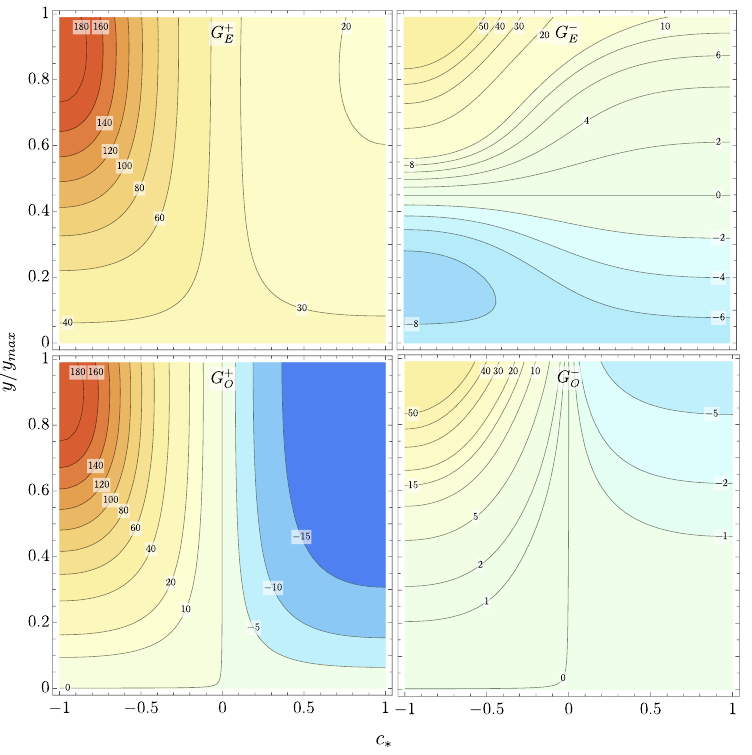
Figure 3 . Logarithmic derivative of the tree-level differential cross-section with respect to the G ± coefficients in the ( c ∗ , y ) plane. The plots are obtained setting m ‘‘ = 1 E,O